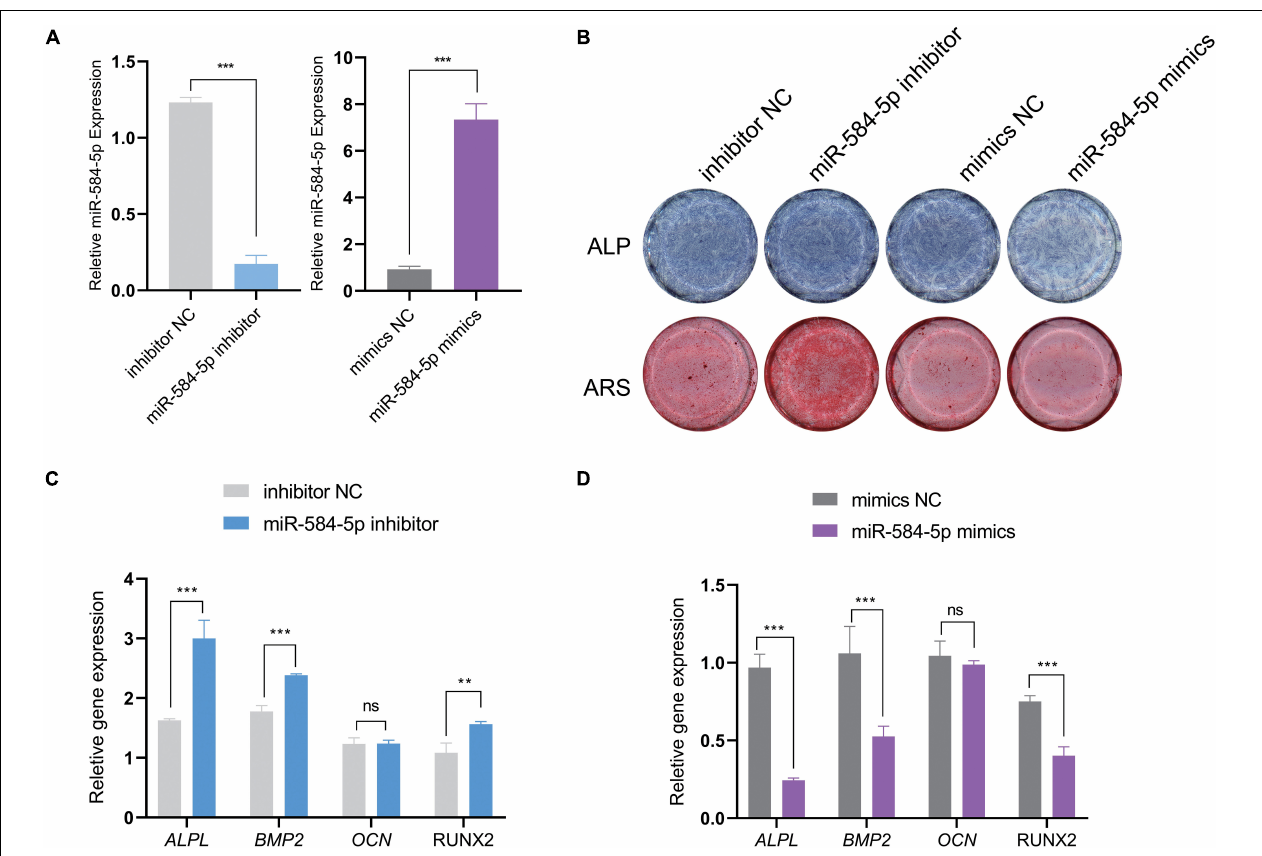
FIGURE 7 | MiR-584-5p regulates the osteogenic differentiation of PDLSCs in vitro . PDLSCs were transfected with inhibitor NC, miR584-5p inhibitor, mimics NC and miR584-5p mimics. After 24 h of transfection, the relative expression of miR584-5p was detected by qPCR (A) . Cells were cultured in osteogenic induction medium for 7, 14 days. ALP staining (7 days) and Alizarin Red staining (14 days) were used to detect ALP activity and the formation of mineralized nodules, respectively (B) . Osteogenesis related indicators ALPL, BMP2, RUNX2 and OCN were used to further prove the osteogenic regulation of miR-584-5p (C,D) . ** p < 0.01 and *** p <